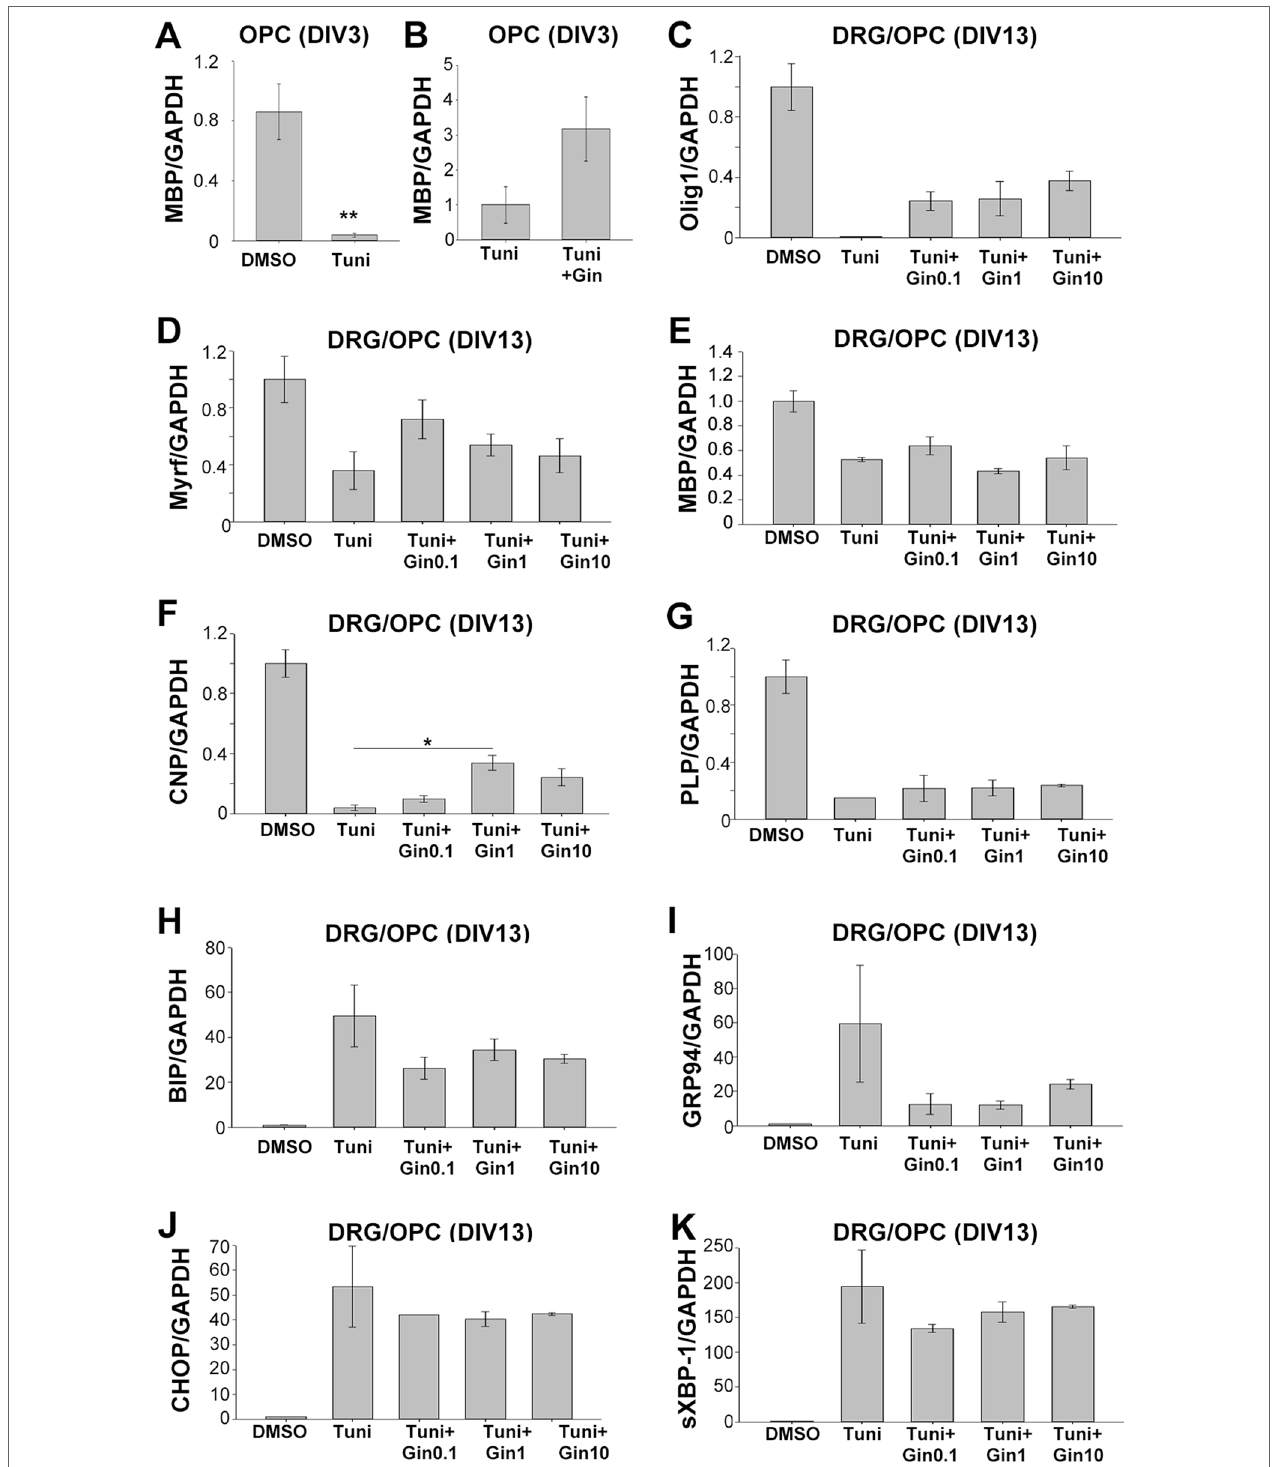
FIGURE 6 | Gintonin reverses the repressed expression of myelin forming-facilitatory genes under ER stress, potentially by modulating UPR responses. Oligodendrocyte precursor cell (OPC) cultures (A and B) or DRG neurons/OPC myelinating cocultures (C – K) were treated with gintonin of the indicated concentrations from DIV1 and ER stress was induced by tunicamycin at the final overnight before the collection of total RNA. At DIV3 of OPC, the expression of MBP was investigated (A and B) . ** p < 0.01, Two-tailed unpaired Student’s t -test, N = 3. At DIV 13 of DRG/OPC cocultures, the expression of myelin forming- facilitatory genes such as Olig1 (C) , Myrf (D) , MBP (E) , CNP (F) , and PLP (G) as well as unfolded protein response-related genes such as BIP (H) , GRP94 (I) , CHOP (J) , sXBP-1 (K) were examined. * p < 0.05, One way ANOVA, Tukey post-test, N = 3. Bars represent mean ±